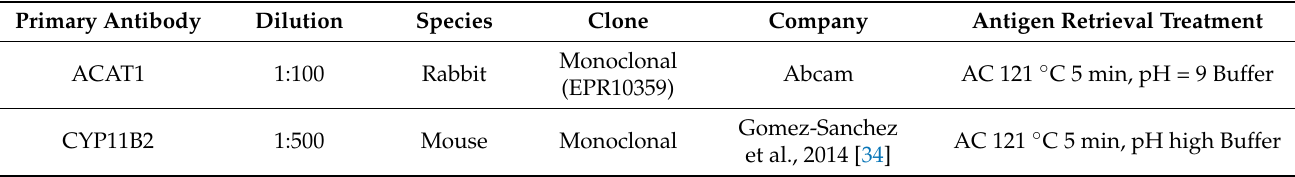
Table 2. Method of immunohistochemical